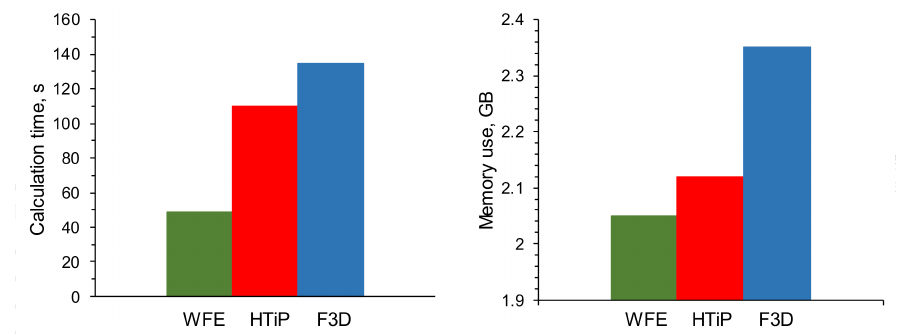
Figure 11. Comparison of the calculation time and memory use of the HTiP, F3D and WFE modelling approaches simulating the 21-day heating phase of a single BHE operation on a PC with Intel Xeon E3-1230 v5